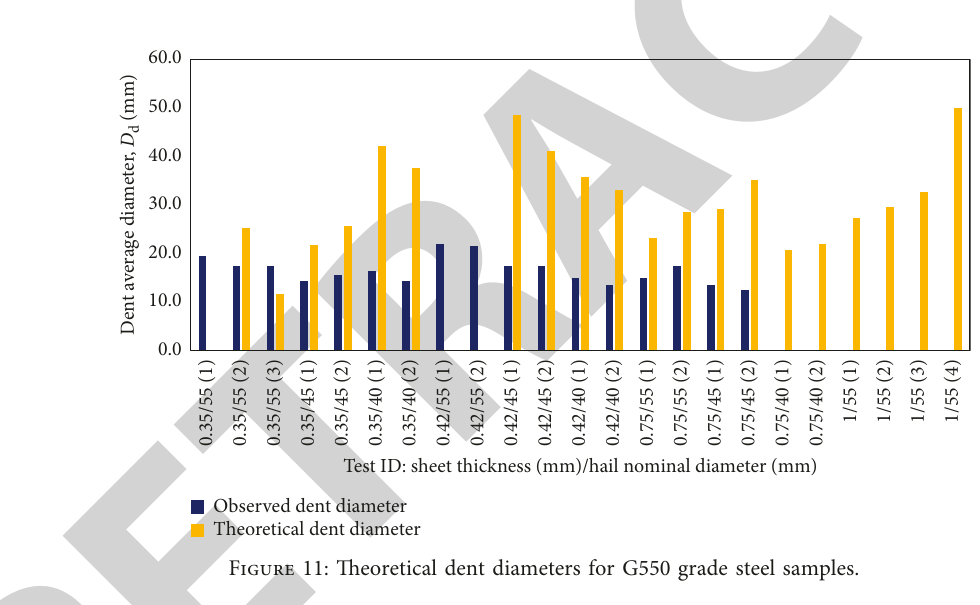
Figure 10: Theoretical dent depth for G300 grade steel samples.